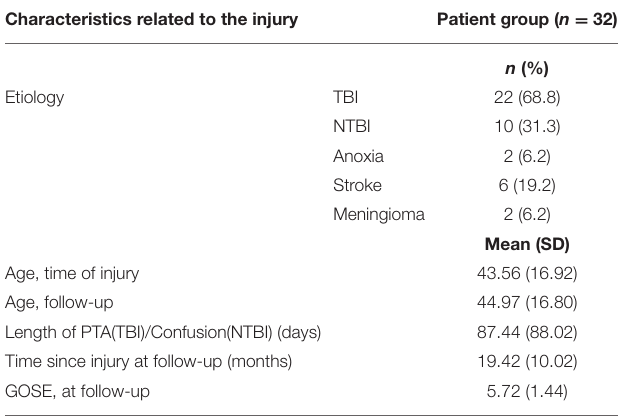
TABLE 3 | Patient characteristics. Characteristics related to the injury